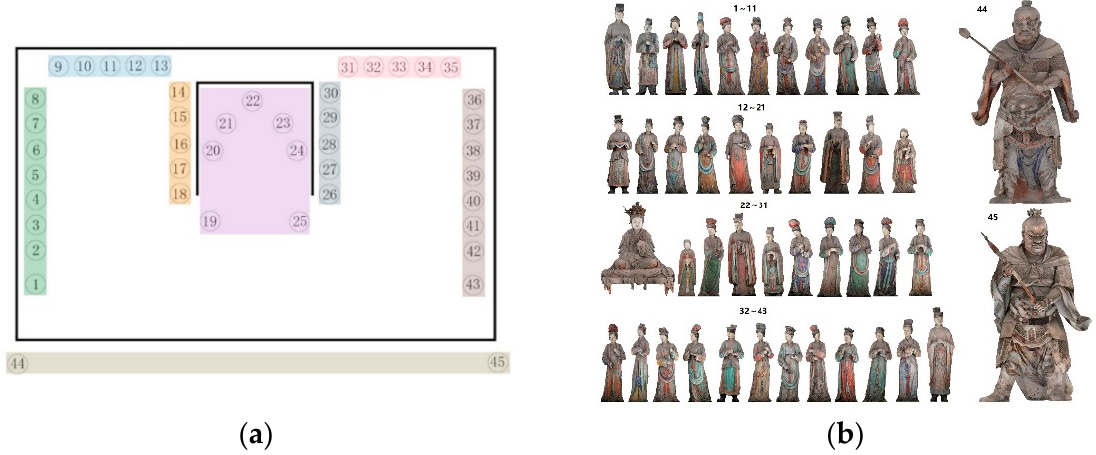
Figure 2. ( a ) Distribution of polychrome statues in the Sage Mother Hall; ( b ) depiction of the polychrome statues in the Sage Mother Hall.